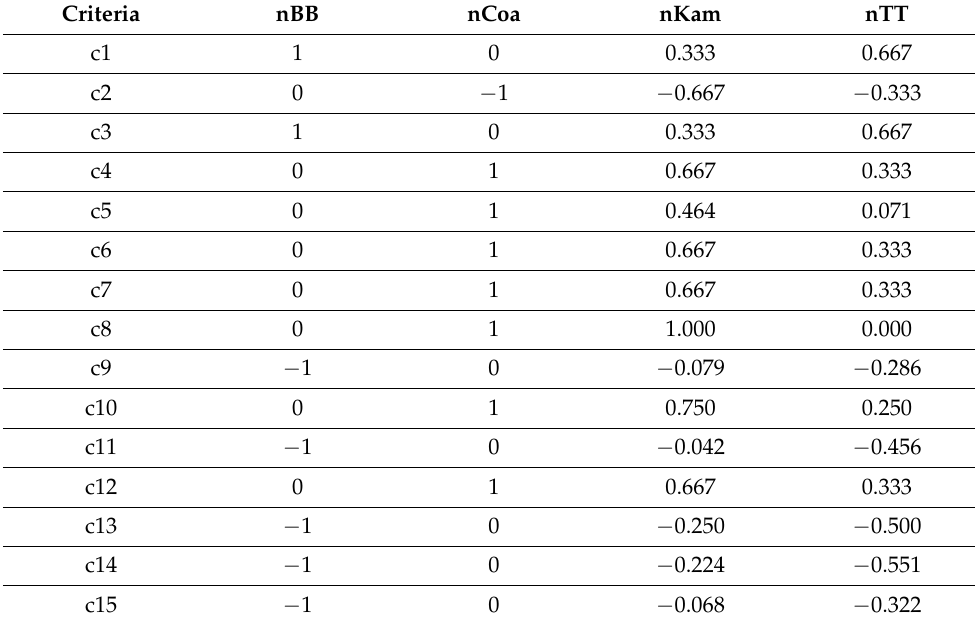
Table 3. Normalized Kalifa MIS with equal orientation.